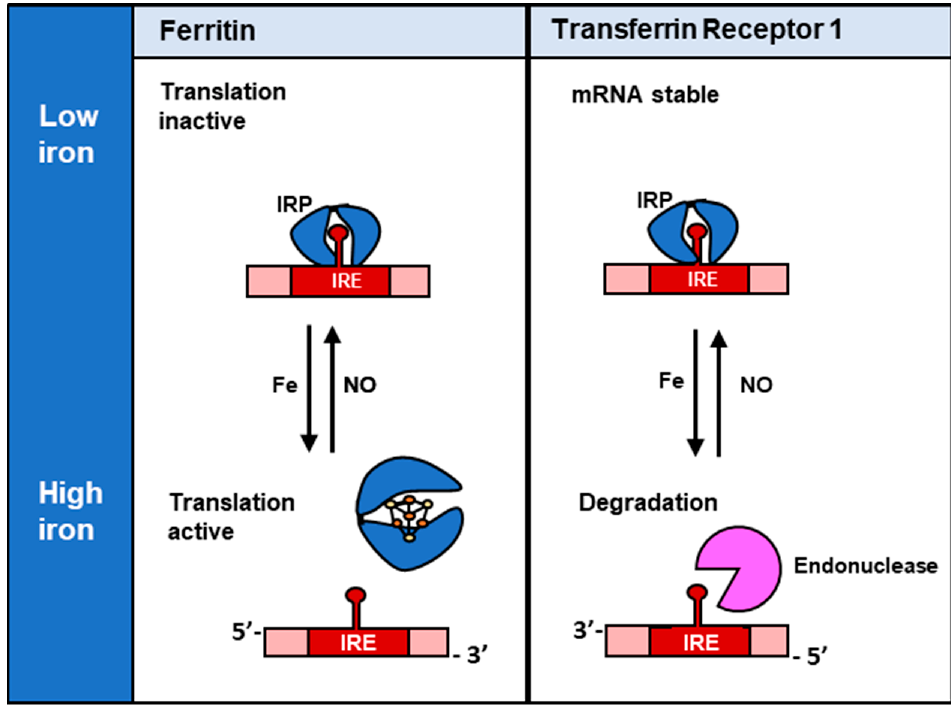
Figure 4. Regulation of ferritin and TfR1 by IRP1. In the absence of iron, IRP1 without an [4Fe-4S] cluster binds the 5 ′ -IRE of ferritin mRNA, which sterically blocks the translation of ferritin. However, in the presence of high iron concentrations, IRP1 cannot bind to the 5 ′ IRE of ferritin mRNA due to the formation of a [4Fe-4S] cluster, and translation is active. On the other hand, when IRPs bind the 3 ′ -IREs of TfR1 mRNA, this interaction stabilizes the mRNA and protects it from endonucleases so that TfR1 translation can occur. Whereas, under high iron concentrations, IRPs cannot bind to the 3 ′ -IREs of the TfR1 , and the mRNA is exposed and degraded by endonucleases. On the other hand, IRP2 is degraded by a proteasomal mechanism when iron is present, and thus can bind IREs under conditions of iron deficiency [104]. For IRP2, it has been discovered that NO and peroxynitrite (ONOO − ) decrease IRP2–RNA binding activity [107–109], which may be induced by NO + -mediated degradation [109]. Although NO’s effect on IRP-RNA-binding activity is well characterized, the biochemistry of NO is complex, as it has multiple iron-containing targets within cells. Richardson and colleagues identified a minimal correlation between increased TfR1 expression and Tf-mediated iron uptake [102], which could be due to NO inhibiting ATP synthesis, causing a disruption in ATP-dependent iron uptake from Tf [110,111]. Taking into account NO’s functional effects on the direct interaction with cellular iron, Hibbs and colleagues proposed a molecular mechanism for the cytotoxicity of ac- tivated macrophages against tumor cells that involves targeting critical iron-containing proteins [13]. In this case, when activated macrophages were co-cultivated with iron-59- labeled tumor cells, there was a marked loss of intracellular iron content within a 24 h incubation [13]. This decrease in cellular iron was associated with the inhibition of tumor cell DNA synthesis and mitochondrial respiration [13]. It has been suggested that the iron released from tumor cells, mediated by NO-activated macrophages, originated from [Fe-S] containing proteins from the electron transport chain [112,113]. This reaction leads to NO and iron forming complexes with GSH or Cys to result in DNICs [112,114,115]. Under NO stress, protein-bound DNICs have been observed in prokaryotic (e.g., Escherichia coli ) and eukaryotic cells, with [Fe-S] proteins being a major target of NO